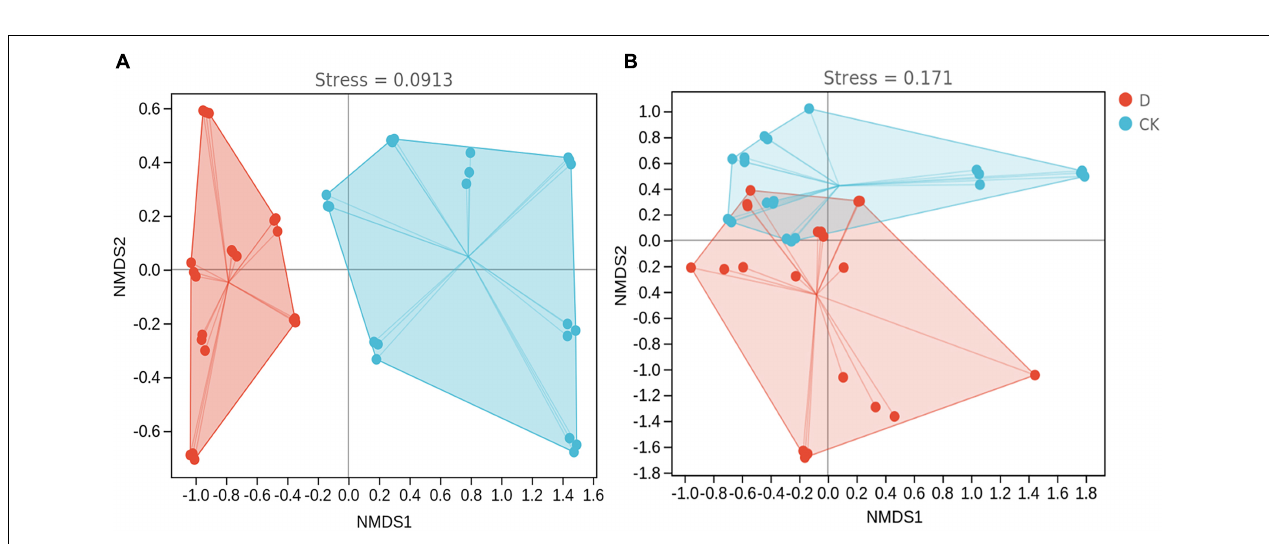
FIGURE 5 | Non-metric multidimensional scaling of (A) bacterial and (B) fungal communities in the garlic cropping obstacle soil (D) and healthy control soil (CK).